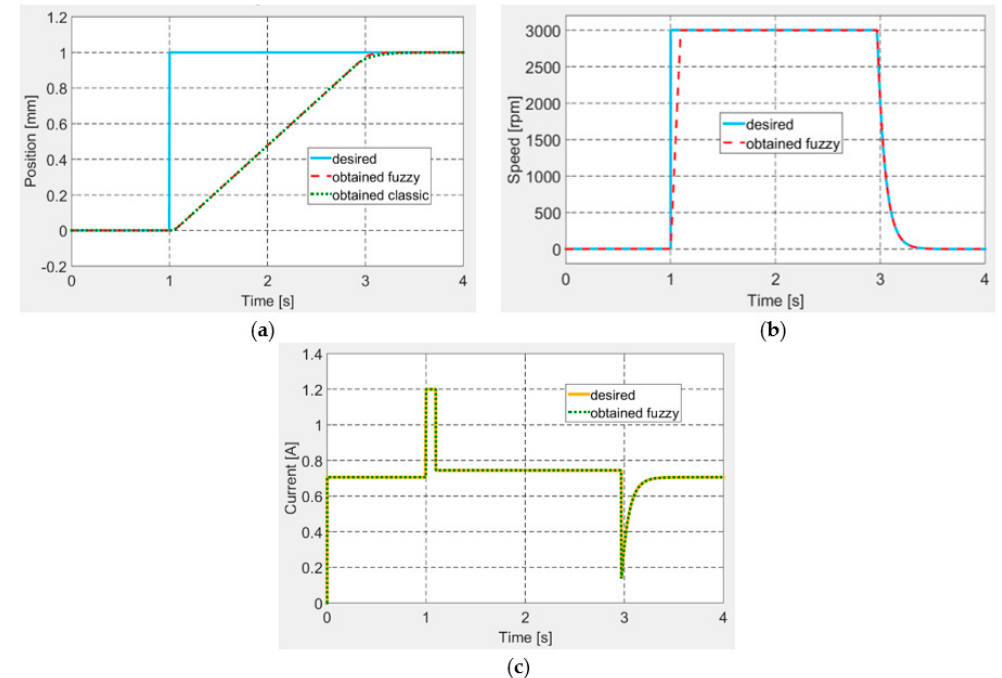
Figure 13. The control results for a step input as desired position: ( a ) position, ( b ) speed, and ( c ) current.